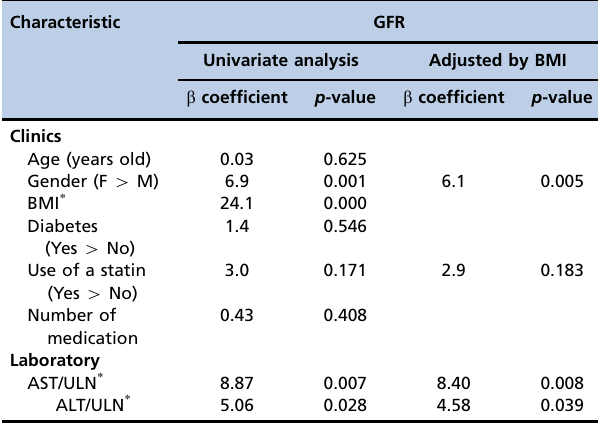
Table 2 - The distribution of clinical and epidemiological characteristics according to the CKD stages of the 142 patients with predialysis CKD.